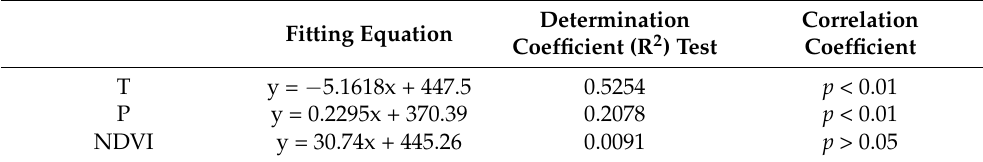
Table 3. Correlation between ET and T, P, and NDVI on the altitude gradient.